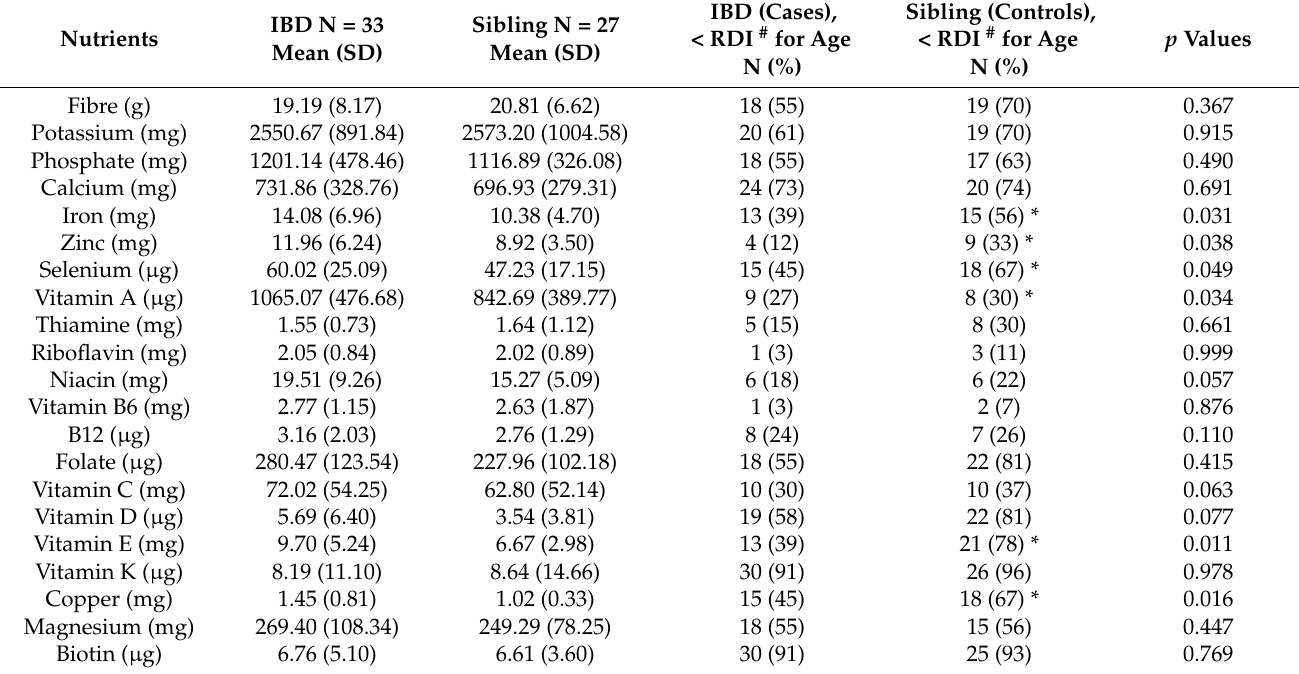
Table 2. Dietary nutrient intakes of cases compared with the controls.